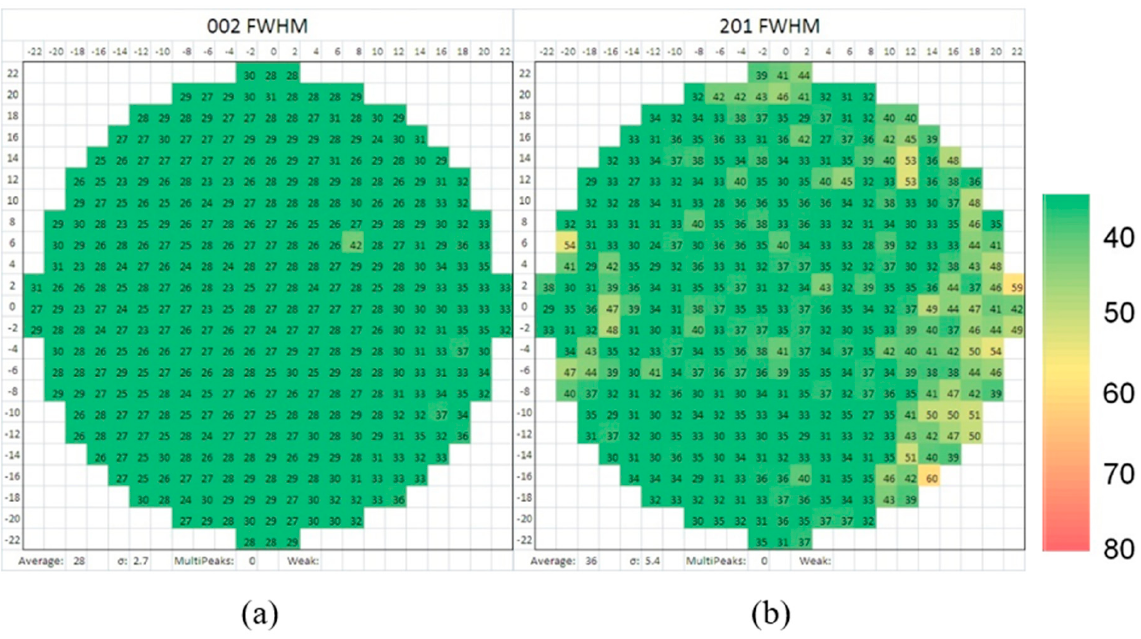
Figure 5. X-ray FWHM maps of a 2 ″ NEAT GaN substrate. The numbers on each axis present position from the center in mm, and the numbers in the boxes and next to the scale bar are the FWHM values in arcsec. ( a ) FWHM of 002 rocking curves; ( b ) FWHM of 201 rocking curves.